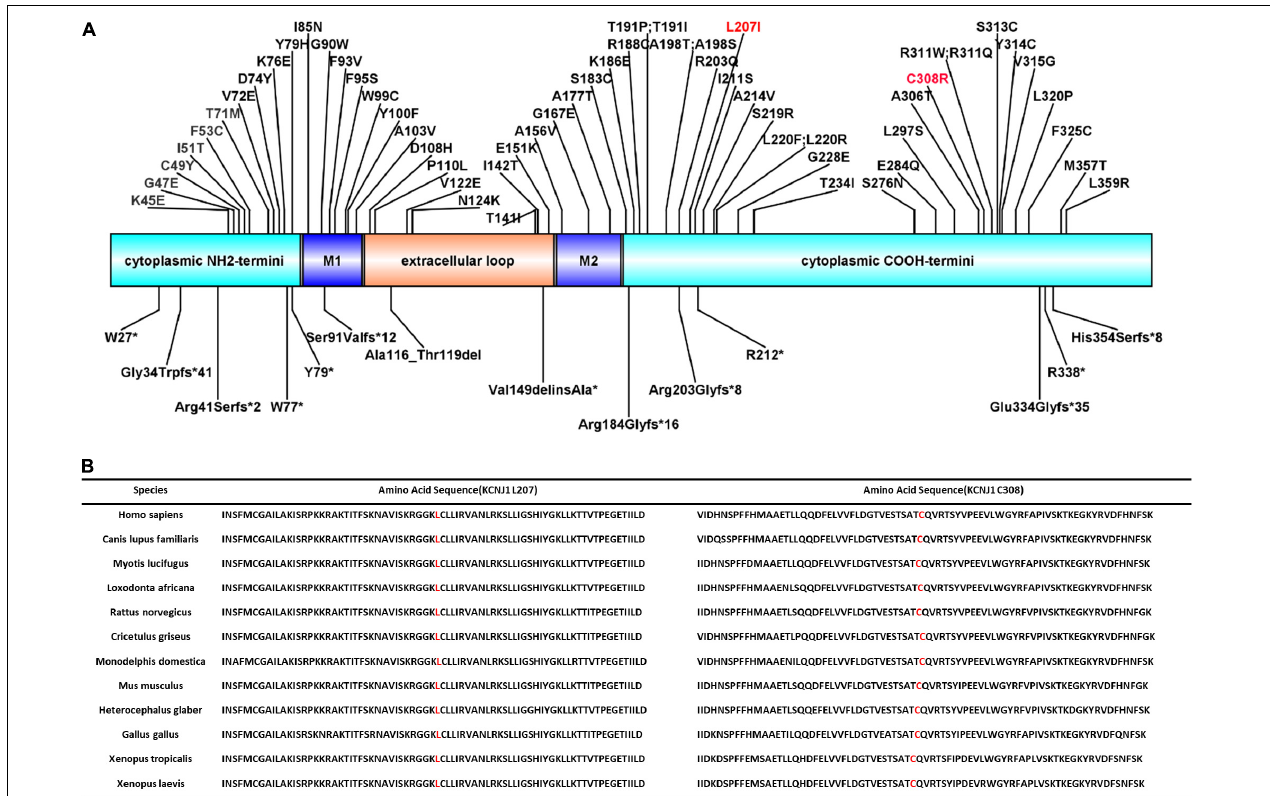
FIGURE 2 | ROMK protein structure and conservation of L207 and C308 among homologs. (A) Domains of the protein with reported mutations associated with type II Bartter syndrome. M1 and M2 represent two transmembrane domains. Red font indicates the mutations reported in this study. (B) Complete preservation of both the leucine amino acid (L207) and cysteine amino acid (C308) among homologs through Xenopus laevis.